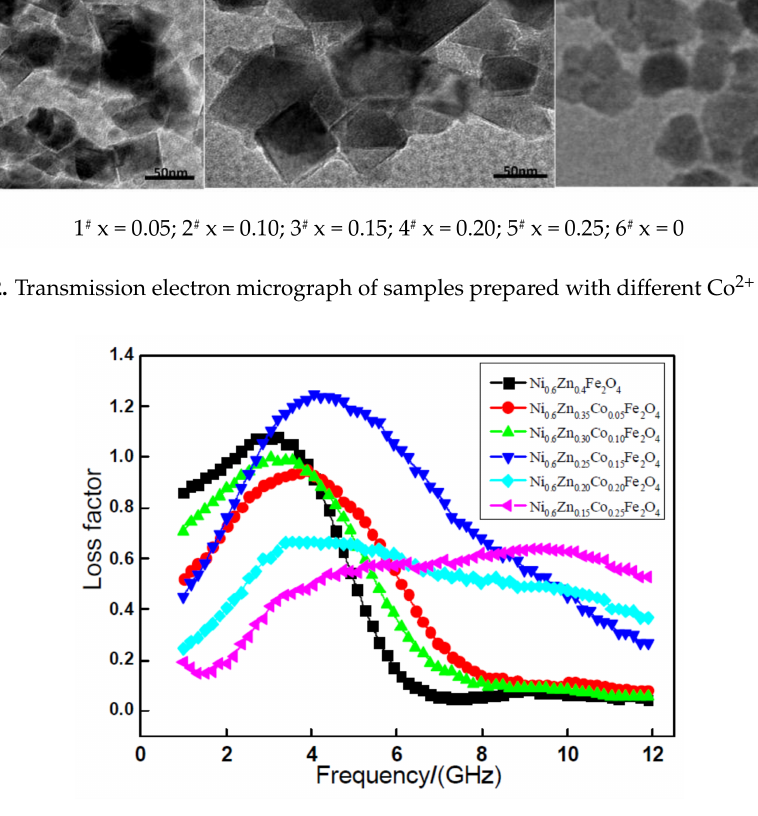
Figure 3. Curves of tan δ and frequency for the Ni 0.6 Zn (0.4 − x) Co x Fe 2 O 4